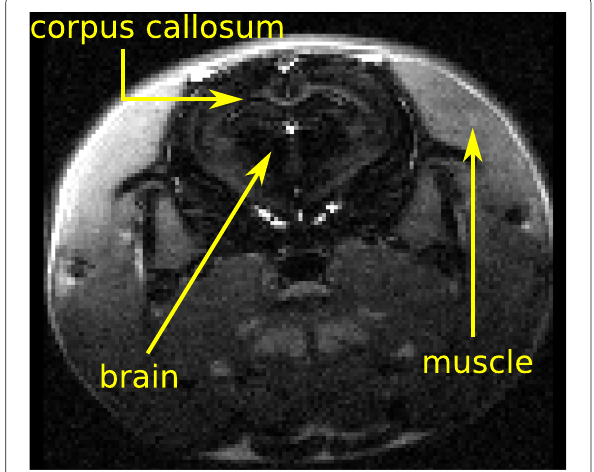
Fig. 7 Transverse section of a rat brain showing the result of the optimal pulse. The aim of the control is to saturate the brain while maximizing the intensity of the surrounding muscle